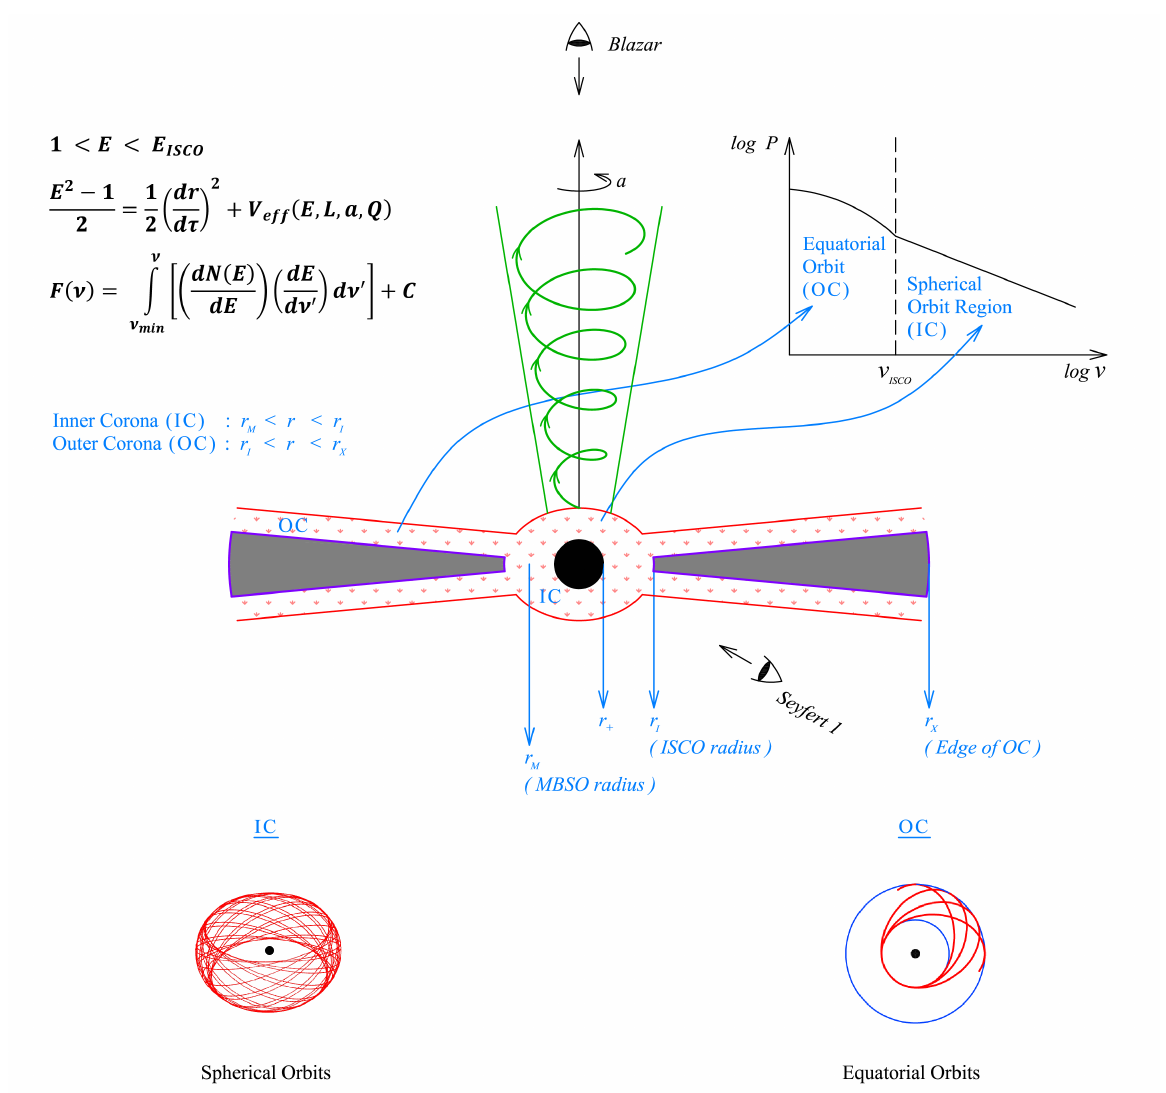
Figure 1. The figure shows a unified picture of the models for X-ray, optical, and γ ray QPOs and the origin of X-ray power spectral density (PSD) shape in AGN. The X-ray QPOs observed in NLSy1 galaxies are associated with the fundamental frequencies of the equatorial orbits in the accretion disk sandwiched by a corona region, which we call the outer corona (OC) region, r I < r < r X ; the inner corona (IC) region, r M < r < r I , is associated with the fundamental frequencies of the spherical orbits around a Kerr black hole. The optical and γ ray QPOs in Blazars are shown as the harmonics of the timescale of a blob of matter moving along the jet. The shape of the PSD is studied using the fundamental frequency of matter which is governed by the radial effective potential, V ef f ( E , L , a , Q ) , providing the gravitational background responsible for the geodesic motion, in IC and OC regions to derive the energy distribution of the orbiting matter, N ( E ) , which is directly related to the observed intensity, I ( ν ) , where ν is the temporal